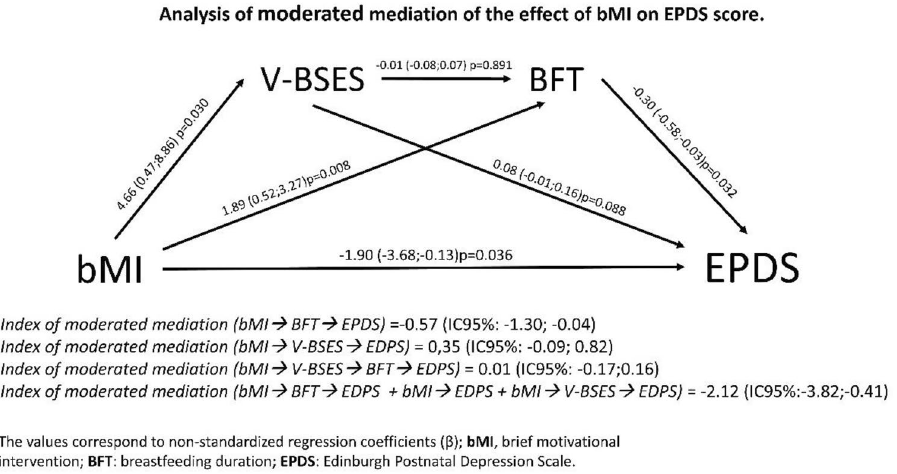
Figure 3. Analysis of the moderated mediation of the effect of the brief motivational intervention on the Edinburgh Postnatal Depression